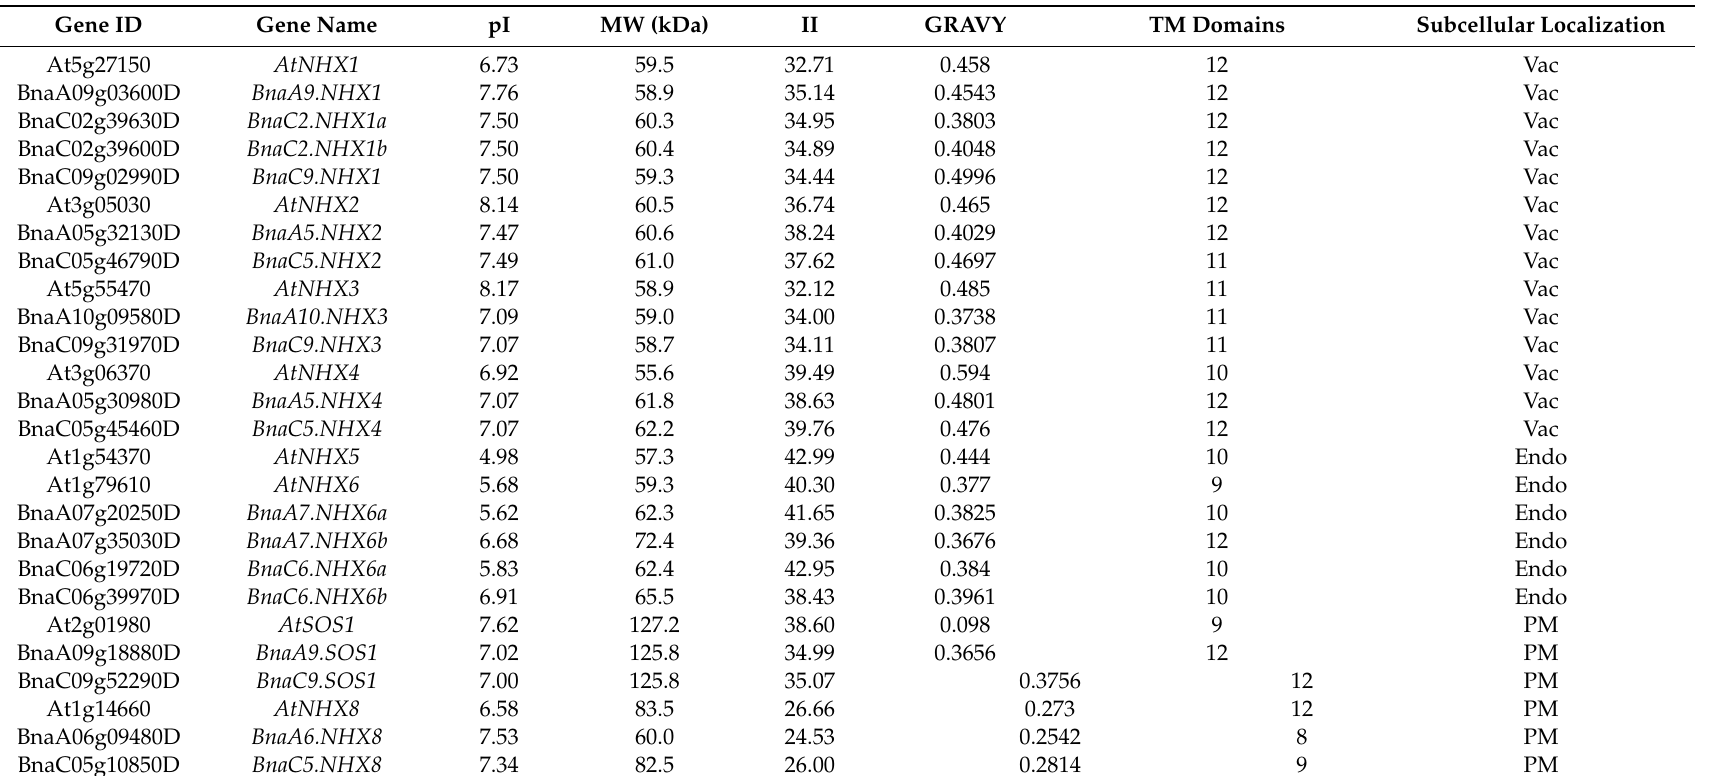
Table 3. Molecular characterization of the Na + / H + antiporters (NHXs) in Arabidopsis thaliana and Brassica